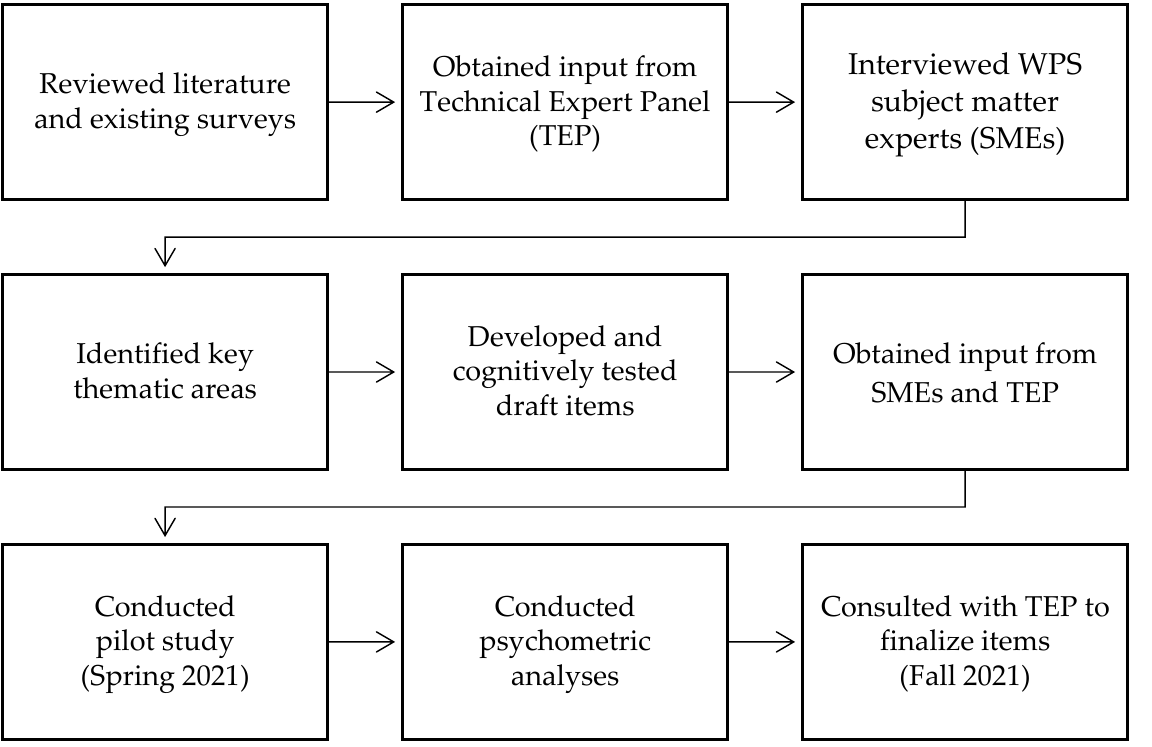
Figure 1. Workplace safety supplemental item development process.